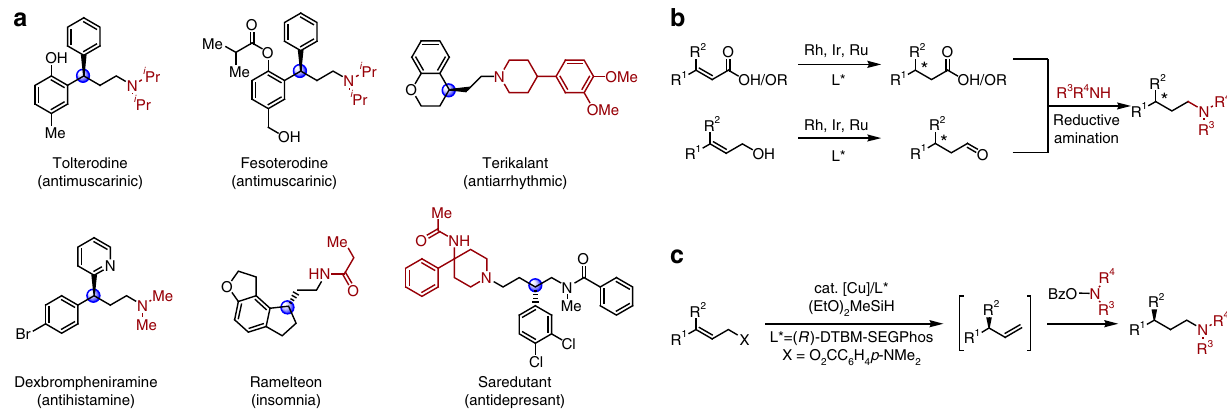
Fig. 1 Signi fi cance and syntheses of chiral γ -branched amines. a Biologically active molecules containing chiral γ -branched amine moiety. b Asymmetric hydrogenation or isomerization followed by reductive amination for the multistep synthesis. c Direct synthesis via a Cu – H catalyzed relay hydroamination